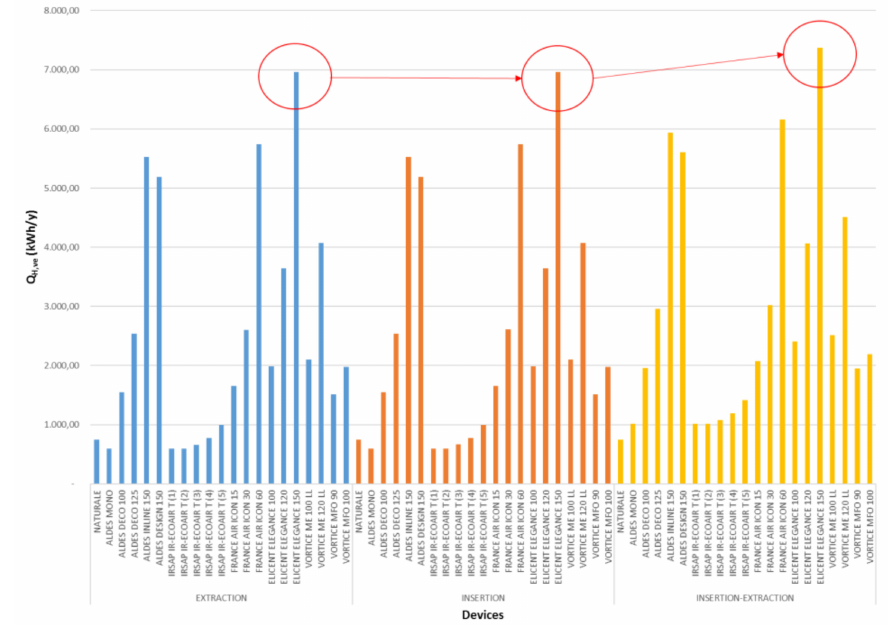
Figure 8. Values of Q H,ve for the three systems of CMV. NB: all the figures use dots and commas as per Italian